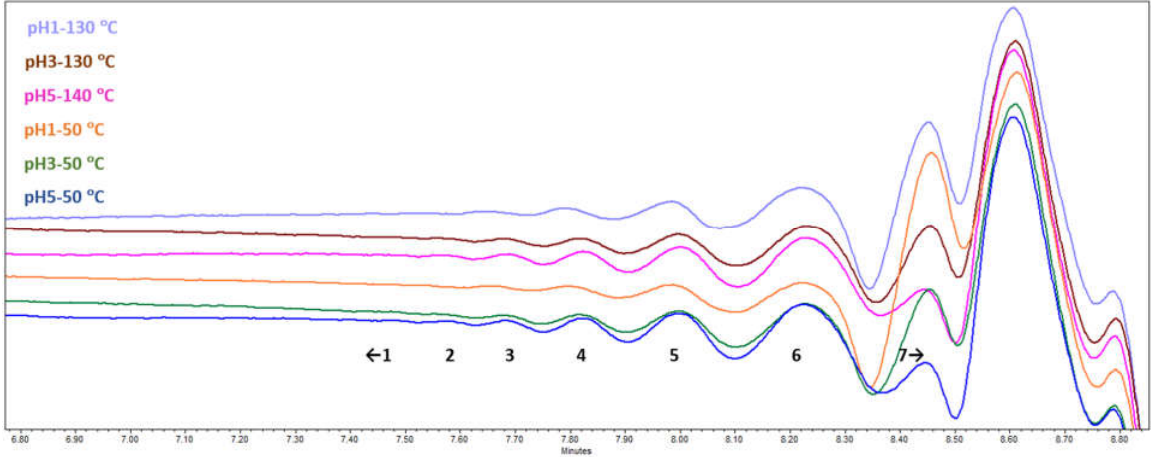
Figure 5. SA sample SEC-RID chromatograms.